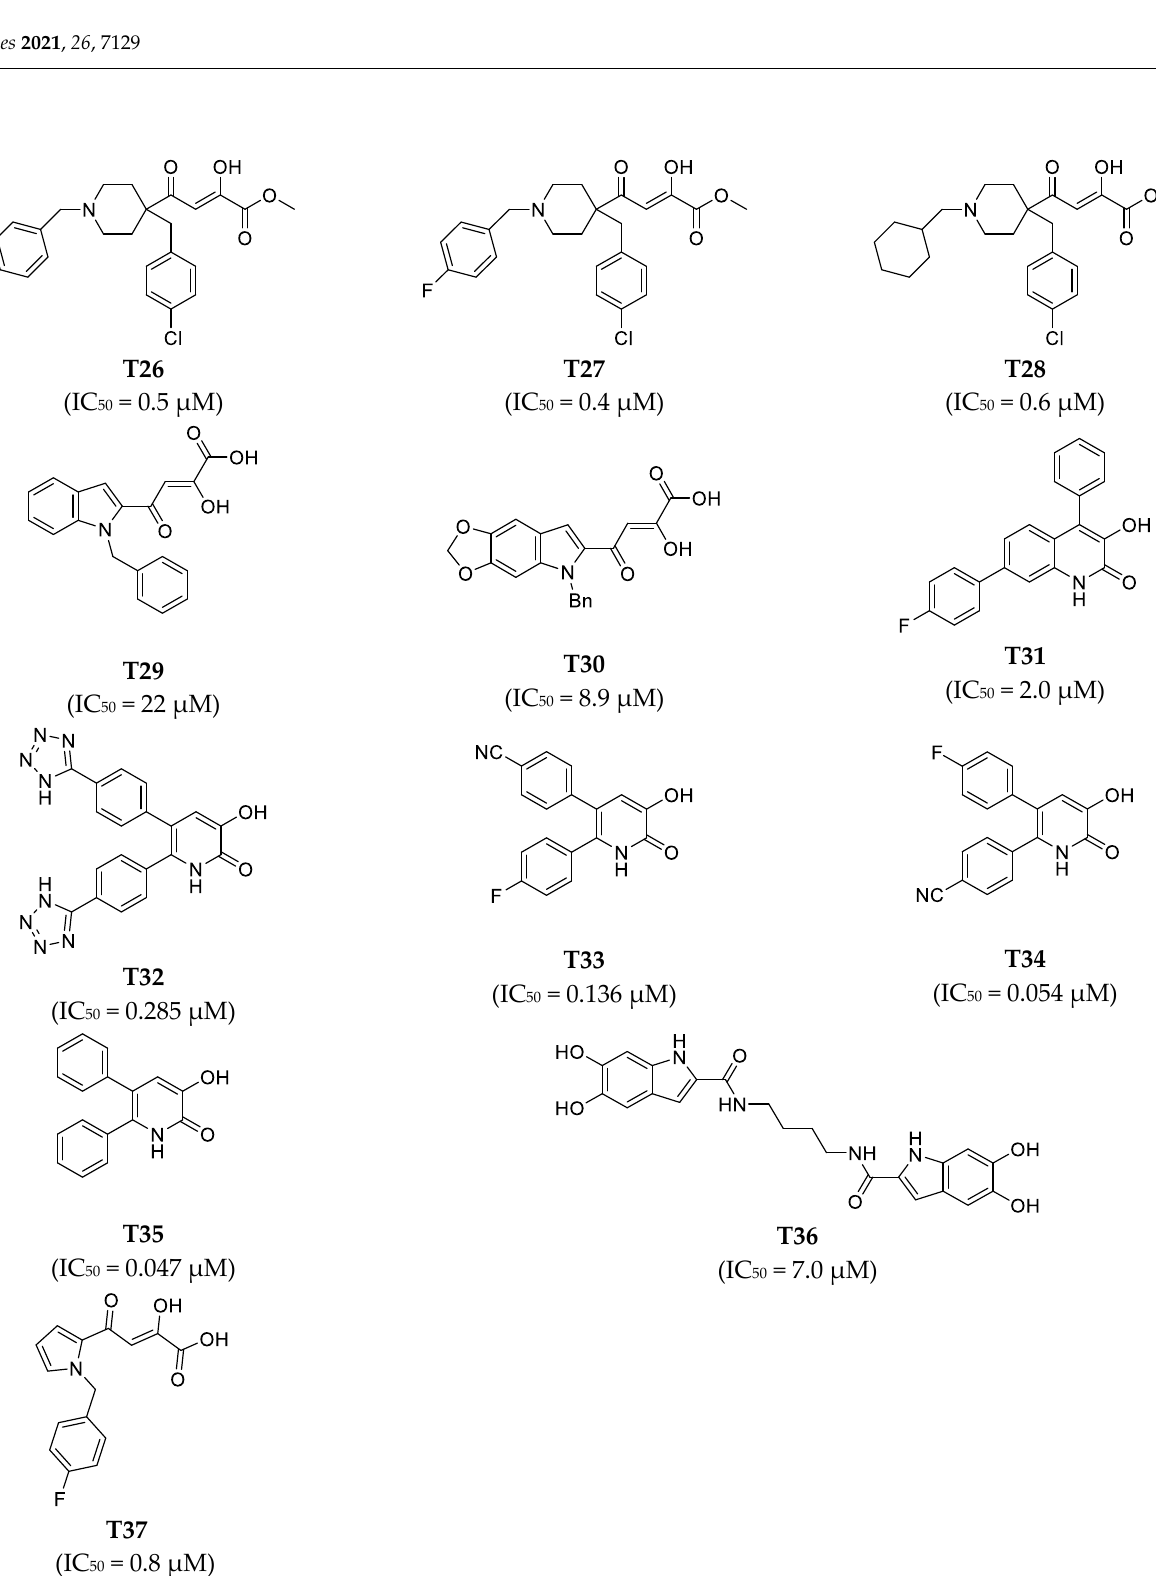
Figure 9. Chemical structures of PA N endonuclease inhibitors in the test set together with their biological activity data (IC 50 value, μM).